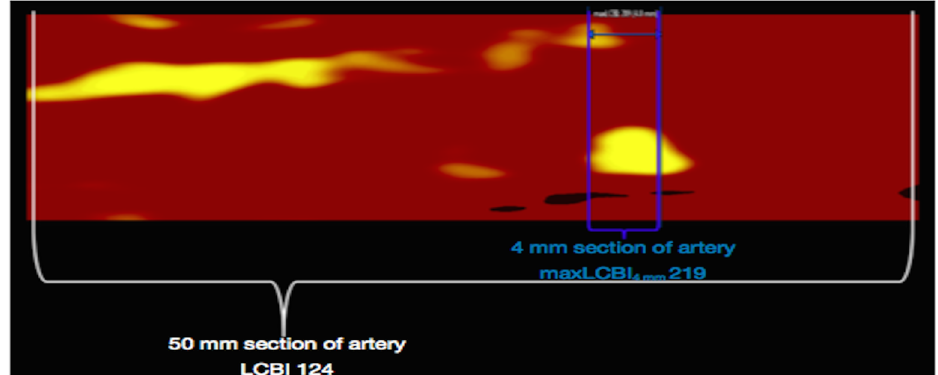
Figure 7. Selection of a region of interest (50 mm segment of the targeted artery, white lines) and the quantification of maxLCBI4mm (the 4 mm segment within the region of interest containing the greatest LCBI, blue lines) by the NIRS software. Reused with permission from AME Publishing Company [80].